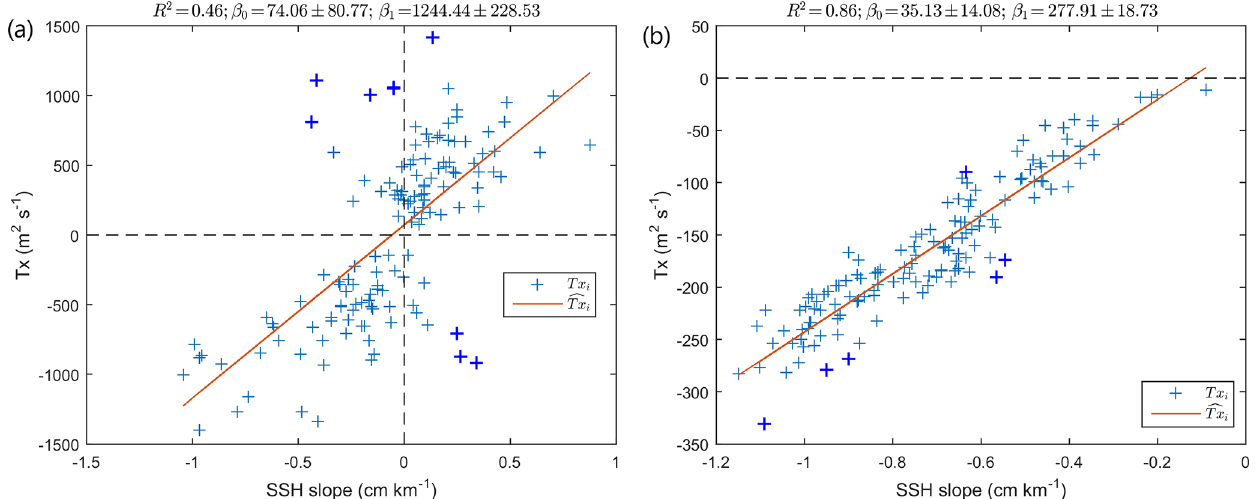
Figure 8. Linear regression models showing the relationship between HYCOM SSH and transport per unit distance (Tx) for ( a ) RM 8, capturing the least transport variance (46%), and ( b ) RM 1, capturing the most transport variance (86%). Txi (blue crosses) represent the Tx values from HYCOM and Txi (red line) represents the Tx estimates from the linear regression model. The bold crosses highlight the residual transport events with transport values greater or less than 2 standard deviations of the transport estimate. The coefficient of determination ( R 2 ) quantifies the amount of variance explained by the regression model; β 0 is the slope coefficient and β 1 the intercept with 95% confidence intervals. Note the different scaling on the x and y axes.